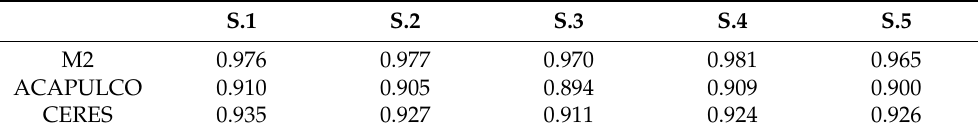
Table 7. DSC comparison between our M2 model, ACAPULCO and CERES.